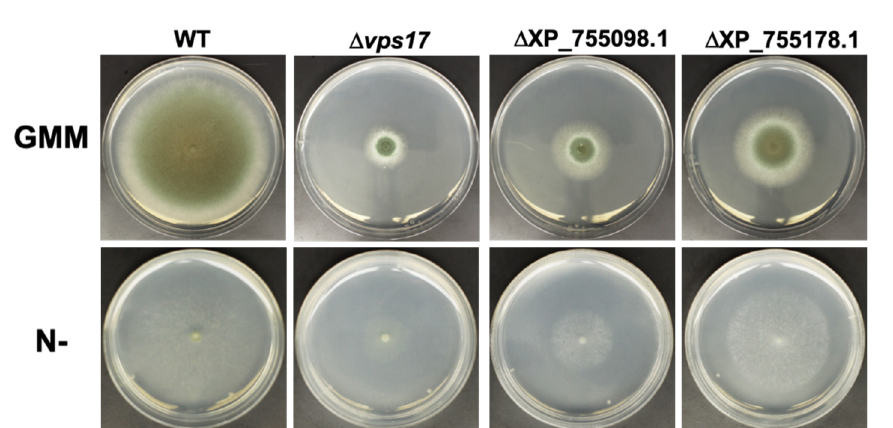
NA = Not available.